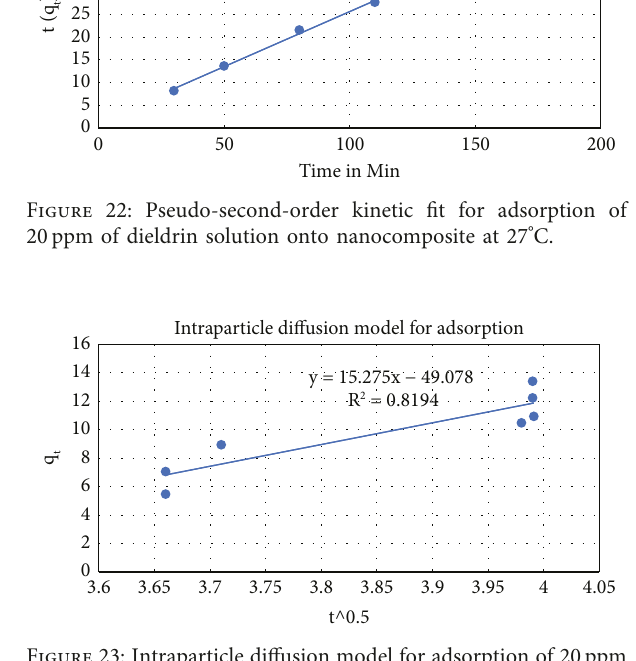
Figure 23: Intraparticle diffusion model for adsorption of 20ppm of dieldrin solution onto nanocomposite at 27 °